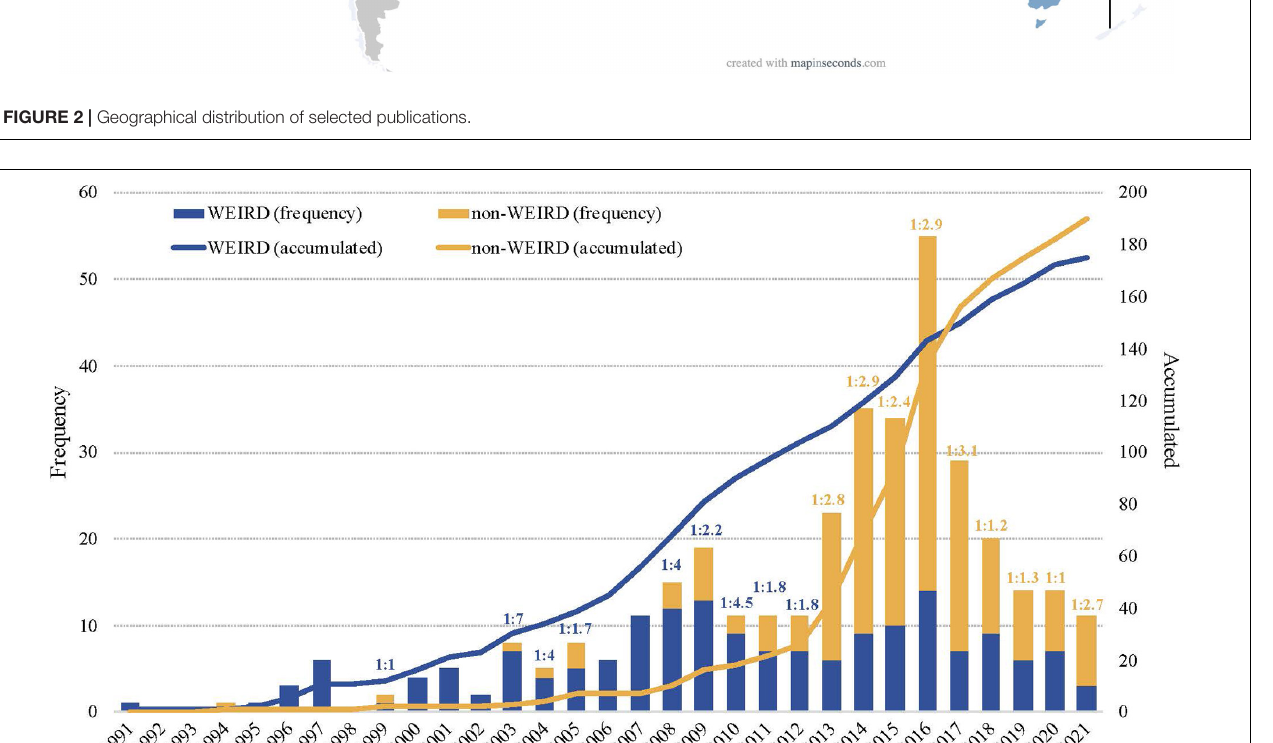
country papers (58.14% of papers and 41.11% of subjects); (c) university students ( n = 25; 2,160 subjects), with more papers published in non-WEIRD countries but similar samples (60% of papers and 49.44% of subjects); (d) social service users ( n = 15; 1,028 subjects), with a majority of WEIRD countries (53.33% of papers and 56.03% of subjects); and (e) company workers ( n = 14; 518 subjects), also with a majority of WEIRD countries (71.43% of papers and